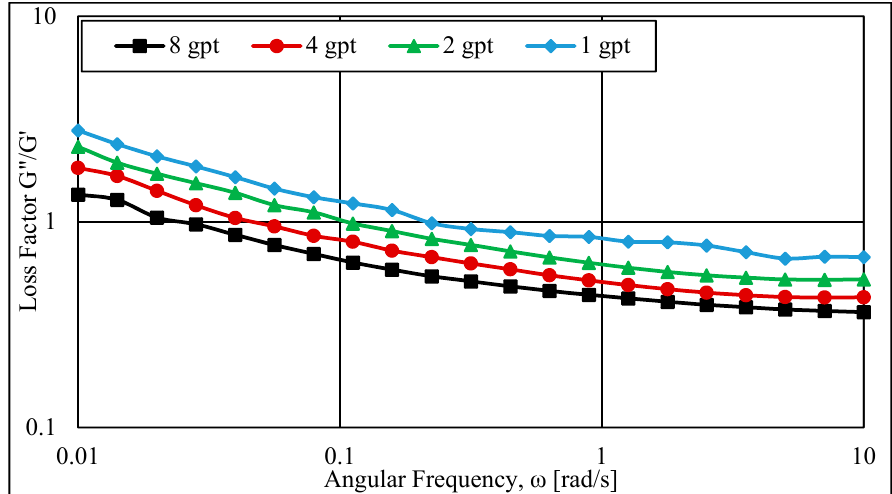
Figure 8. Loss factor (G ″ /G ′ ) of the HVFR.